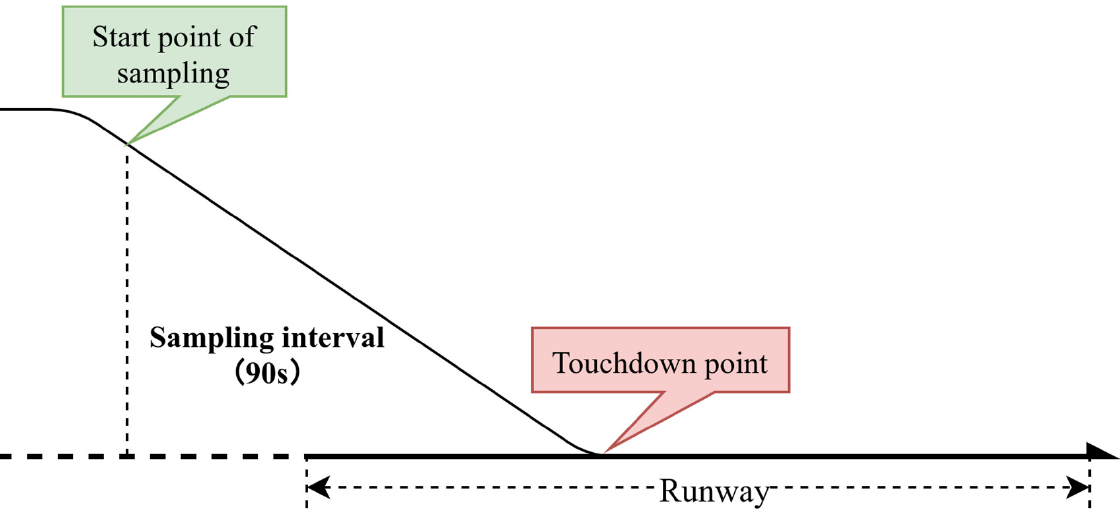
Figure 3. Flight phase of data sampling.